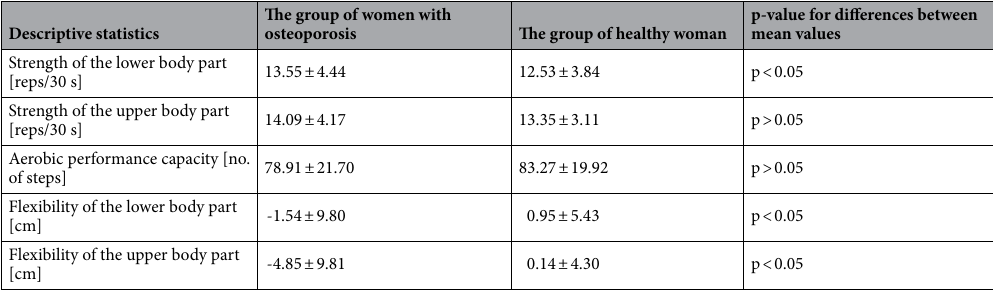
Table 5. Basic characteristics for senior fitness test batteries in both groups.